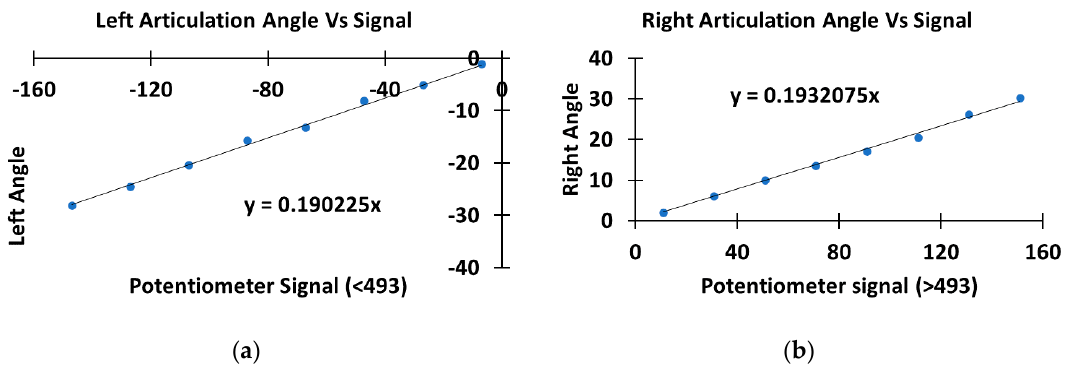
Figure 5. The calibration of the potentiometer and articulation angle. The left image ( a ) presents the relationship of the left articulation angle versus the potentiometer signal. The left image ( b ) shows the relationship of the right articulation angle versus the potentiometer signal.